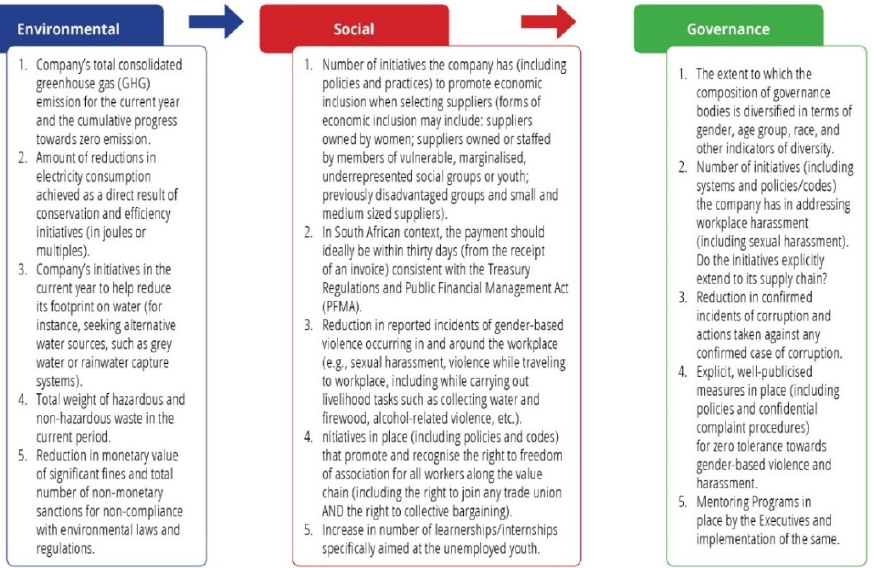
Figure 5. Non-financial performance metric for determining executive compensation. Source: Matemane (2022).